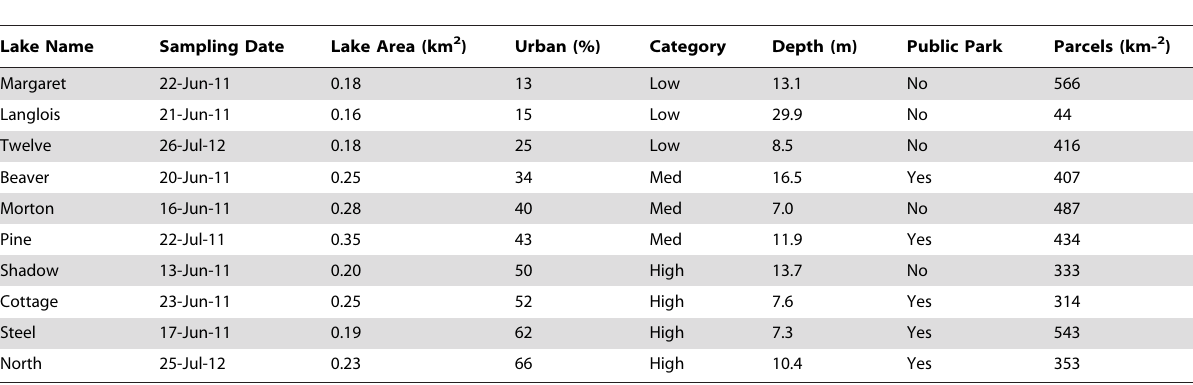
Table 1. Characteristics and dates of lakes